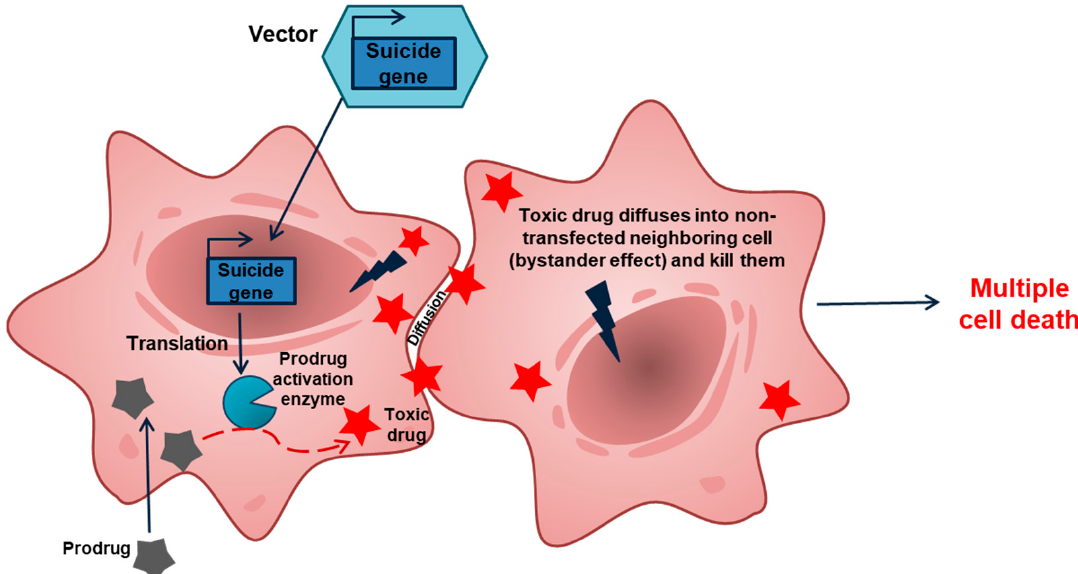
Figure 1. Overview of the GDEPT approach. Cancer cells are transfected with a construct carrying a suicide gene. Due to transfection, a fraction of cancer cells take up the gene, while other cells remain intact. Expression of the suicide gene within the cancer cells produces an enzyme that converts a prodrug into a toxic drug that leads to cell death. This toxic drug may diffuse into the surrounding cells (bystander effect) and kill them.